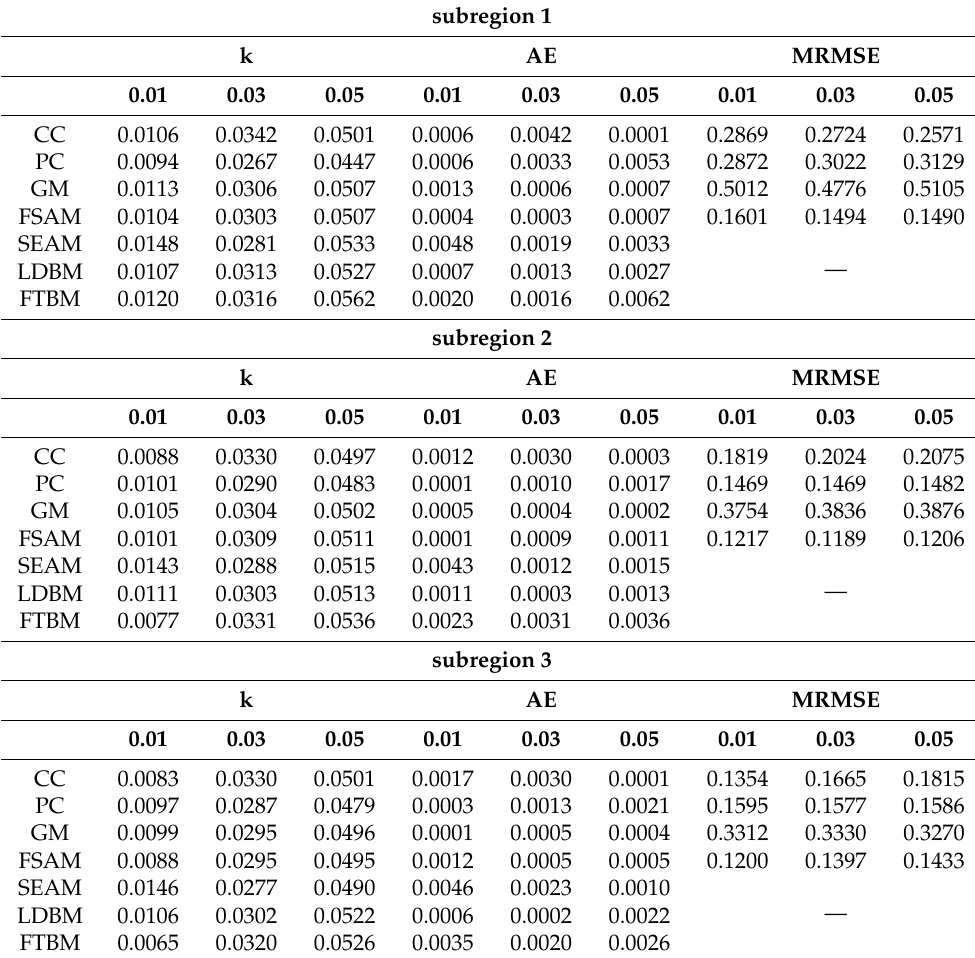
Table 1. The results of all test methods on subregion 1, subregion 2, and subregion 3.